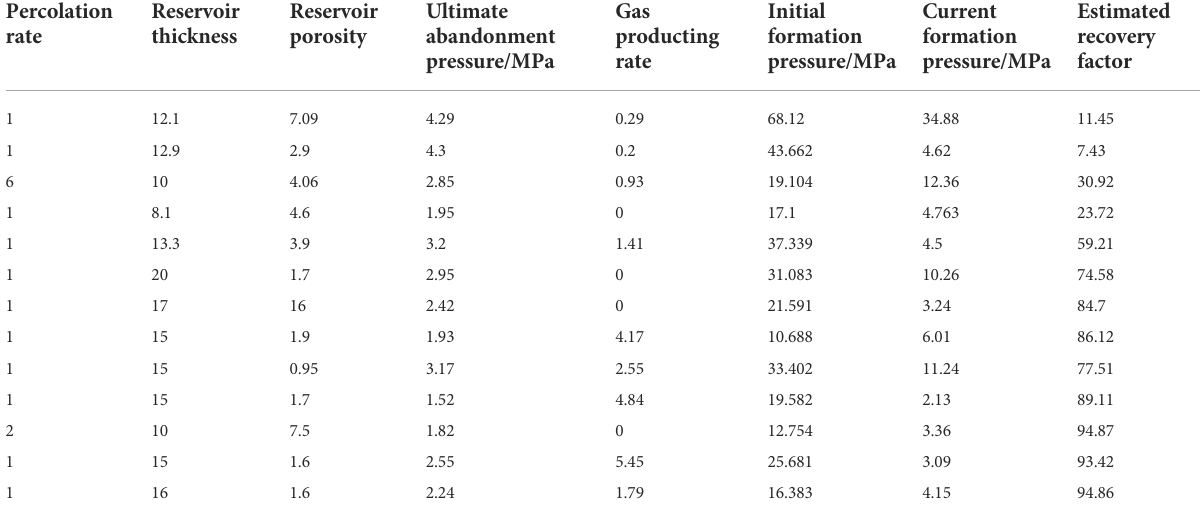
TABLE 1 In fl uencing factors of Gas reservoirs in Jialingjiang